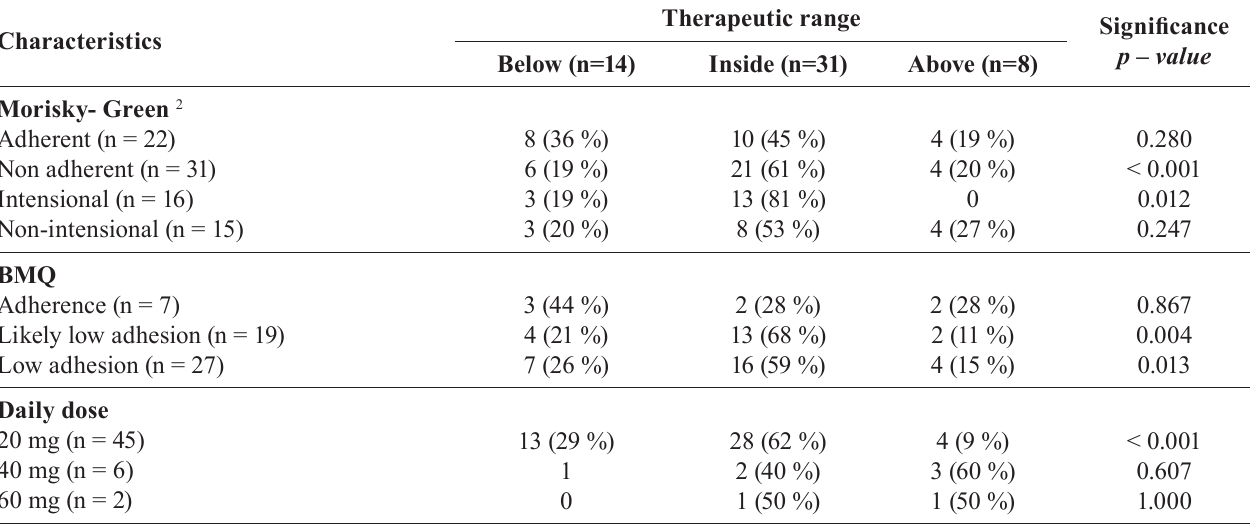
TABLE IV - Distribution of the classified fluoxetine users according to their adherence level (using Morisky-Green and BMQ classifications) and therapeutic range (FLU +